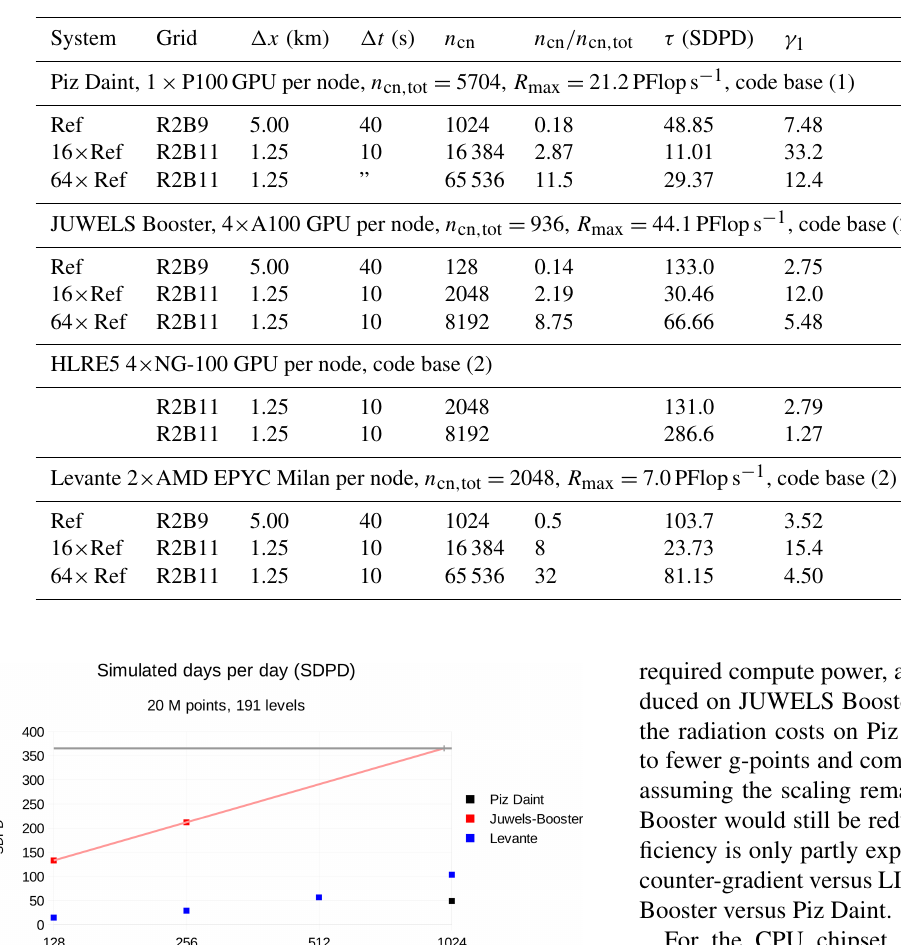
Table 4. ICON R2B11 configurations and their expected turnover. Compute system with processor type, its total number of nodes and the R max LINPACK benchmark, and ICON code version, ICON grid, horizontal resolution ( (cid:49)x ), time step, number of nodes, fraction of nodes with respect to the total number of nodes, temporal compression τ (in SDPD), the gap factor, γ 1 for 1 simulated year per day, defined as γ 1 = 365 . 25 /τ , and the required computational power P 1 = R · γ 1 , where R = n cn /n cn , tot · R max , and given in units of exaflops per second (EFlops − 1 ) required to simulate 1 year per day of the indicated model on the indicated configuration of the machine, assuming ideal strong scaling for a speedup of γ 1 . Because we use the LINPACK references for R max , the n cn , tot for Levante is not its present node count but the number used in the November 2021 benchmarks.